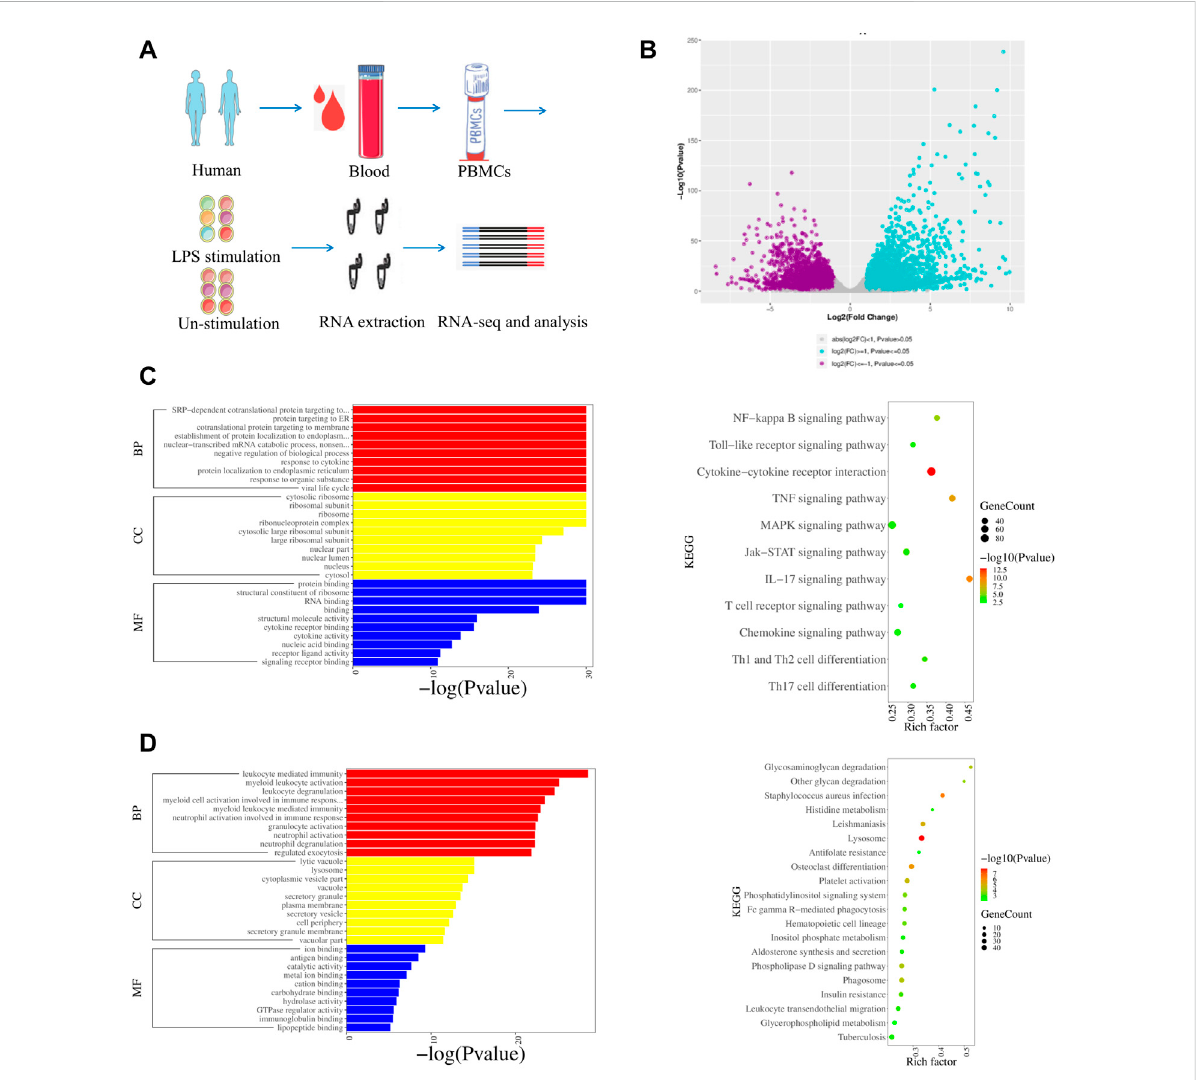
FIGURE 3 Transcriptomicpro fi lesofLPSstimulatedandLPS-unstimulatedPBMCsfromhumansbyRNA-seq. (A) Flowdiagramoftheexperimentaldesign. (B) Volcano plot shows the DEGs by comparing the LPS-stimulated PBMCs and LPS-unstimulated PBMCs from humans at the time point of 6 h. Signi fi cantly differentially expressed genes were de fi ned by both p -value (less than and equal to 0.05) and fold change (greater than and equal to 2). (C) GO and KEGG enrichments of upregulated DEGs for the group of LPS-stimulated PBMCs vs. LPS-unstimulated PBMCs from humans by RNA-seq. (D) GOandKEGGenrichmentsofdownregulatedDEGsforthegroupofLPS-stimulatedPBMCsvs.LPS-unstimulatedPBMCsfromhumans by